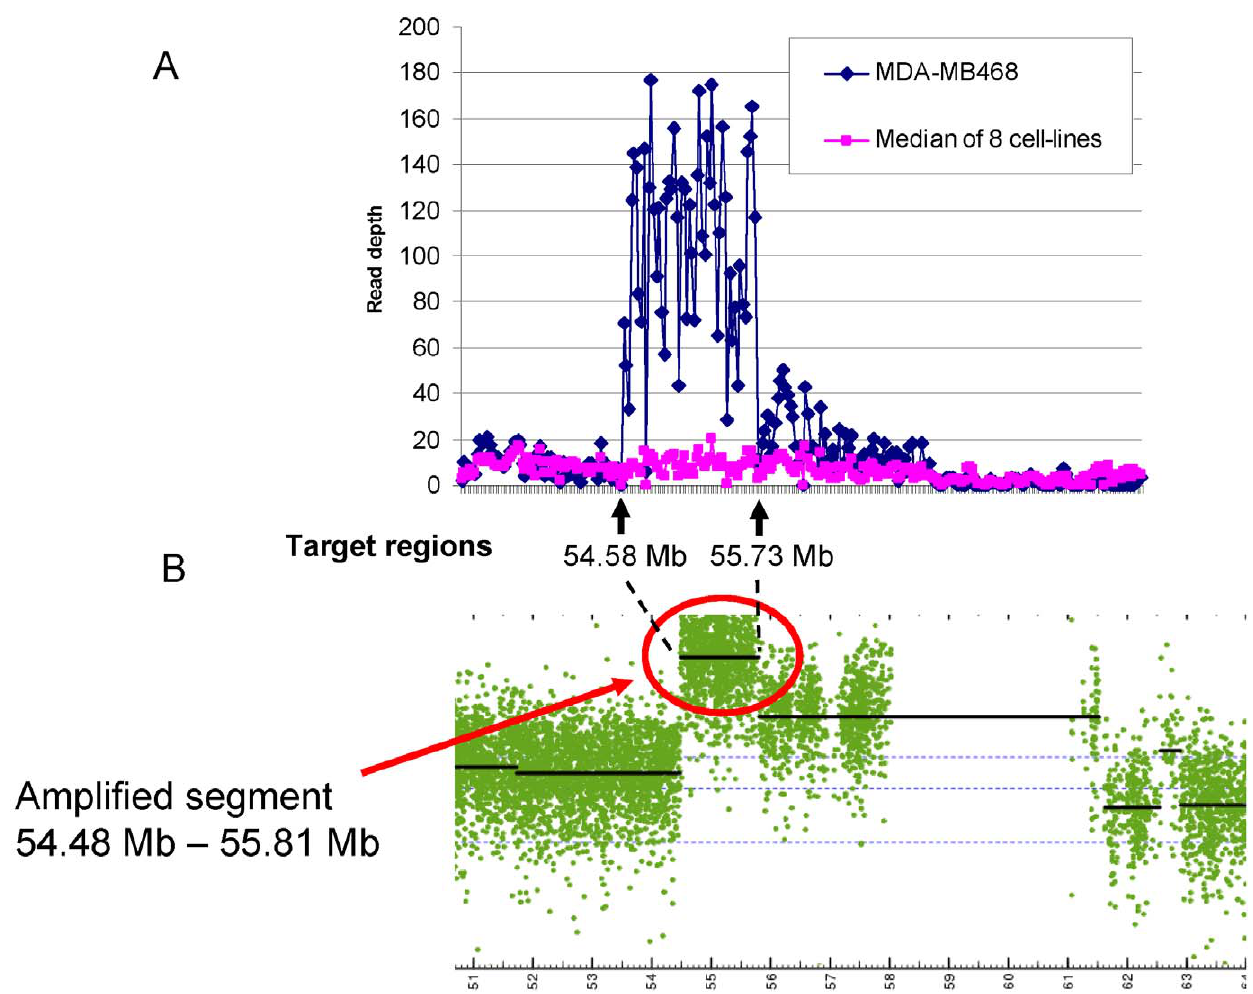
Figure 4. Sequencing read depth and amplification around the EGFR gene on chromosome 7 in the MDA-MB468 cell line. A . Plots of read depth data on consecutive exons around the EGFR gene region on chromosomal 7. The blue line shows sequencing read depth data for MDA- MB468, and the pink line shows the median sequencing read depth of all eight cell lines. B . Copy-number data from Affymetrix SNP6 chip data around the EGFR gene region on chromosomal 7. The black line shows the segmented copy-number data (log2 ratio to normal samples) generated by the aroma.affymetrx package in R as described in the methods section.